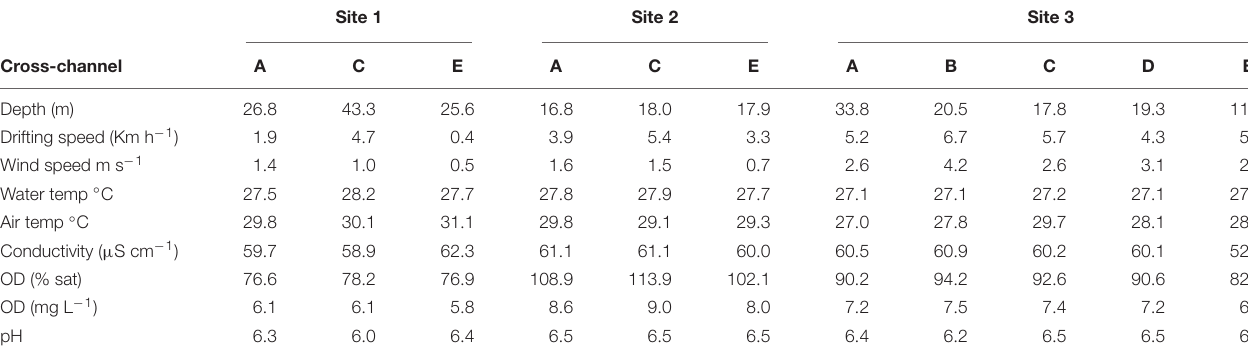
TABLE 1 | Characterization of the sampled sites along the cross-channel measurements. Site 1 Site 2 Site